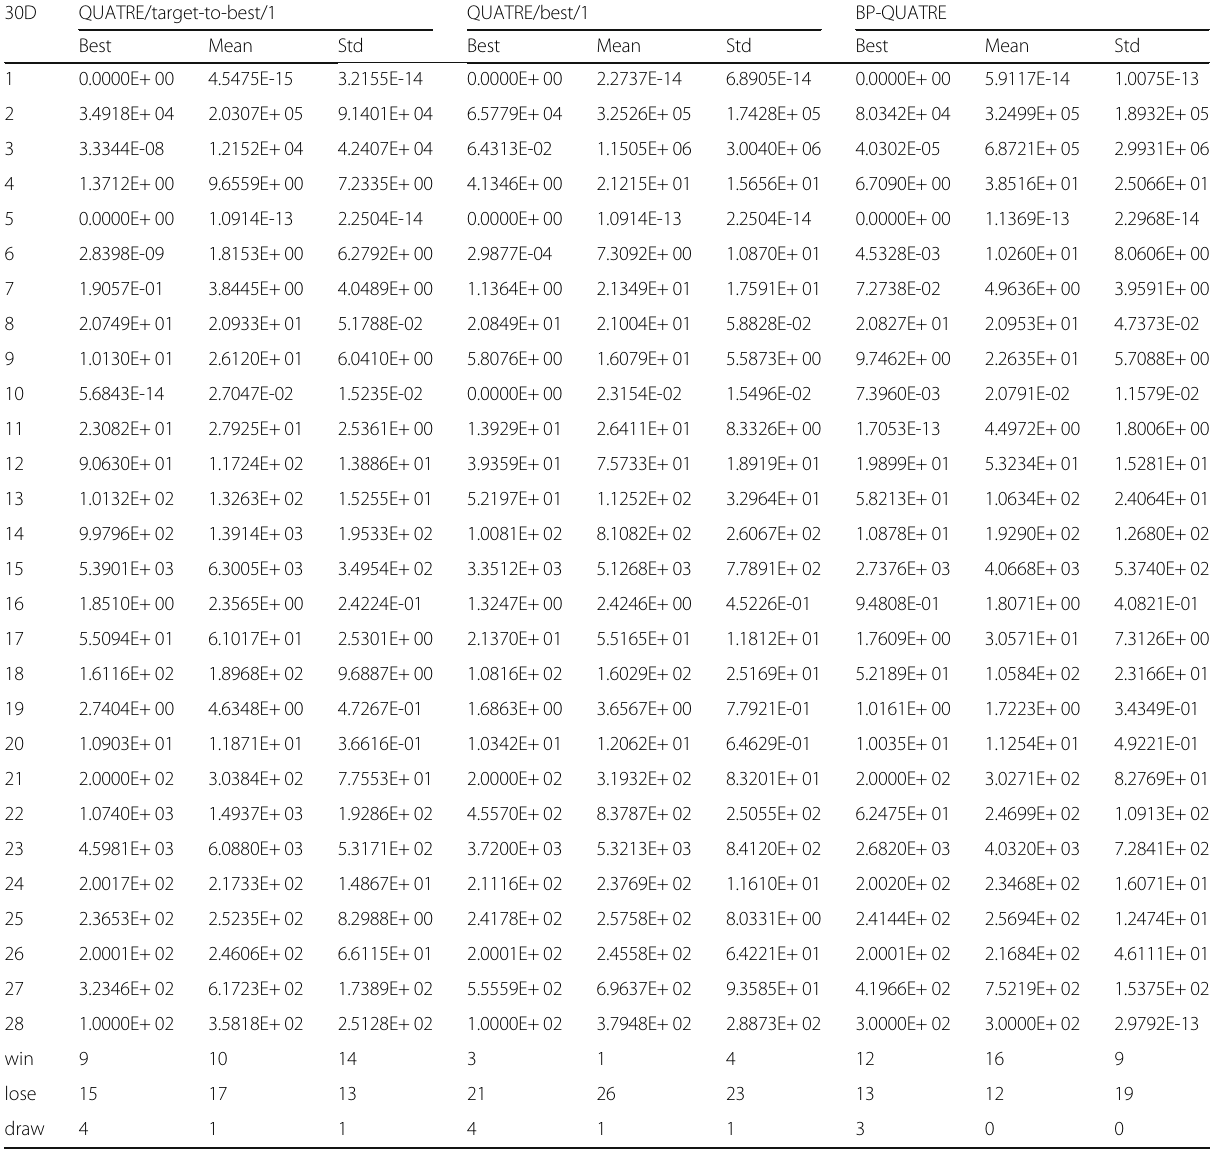
Table 2 Performance for BP-QUATRE, QUATRE/target-to-best/1, and QUATRE/best/1 30D